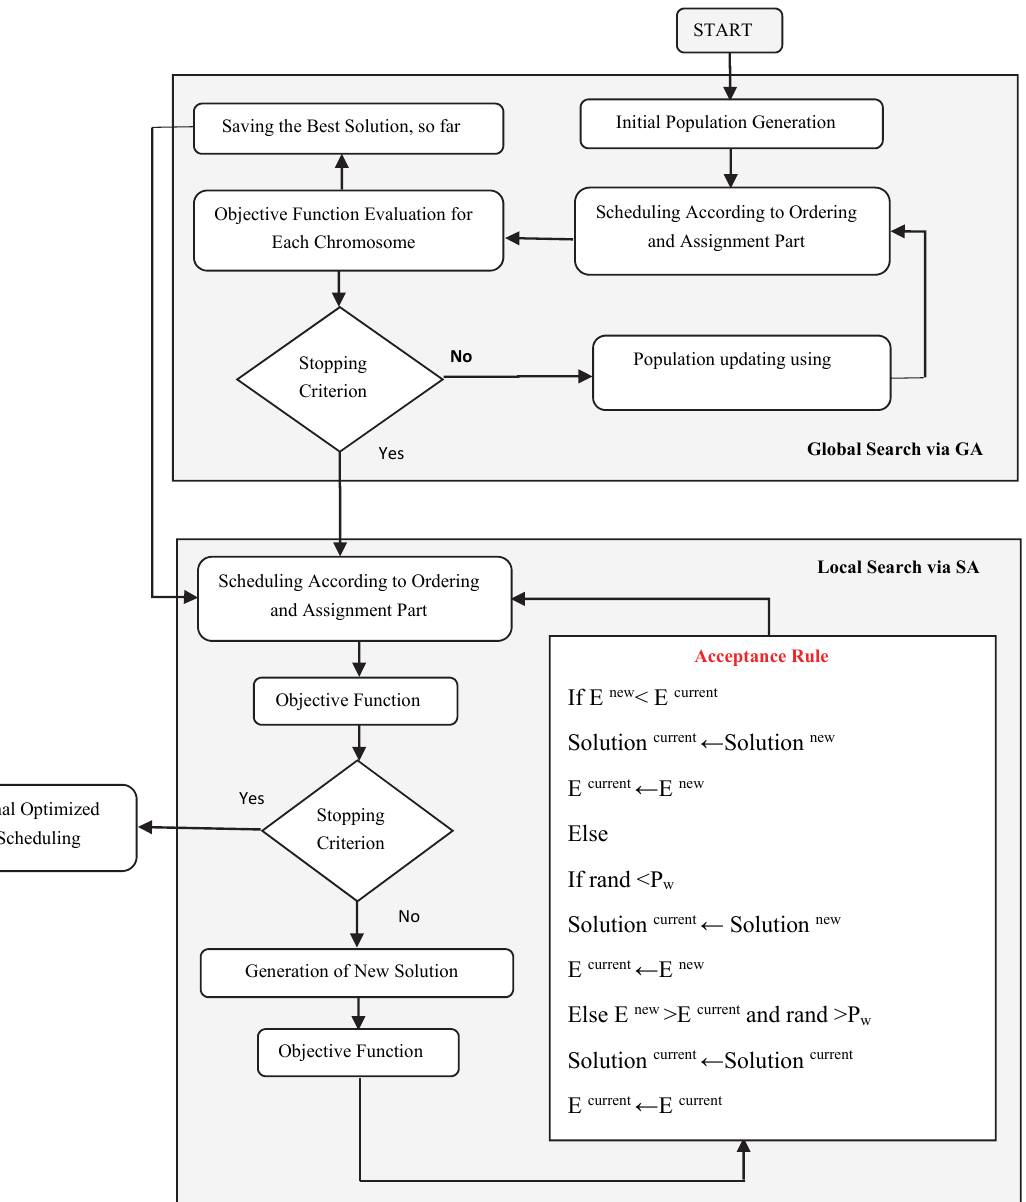
Fig. 1. Flowchart of the proposed scheduling